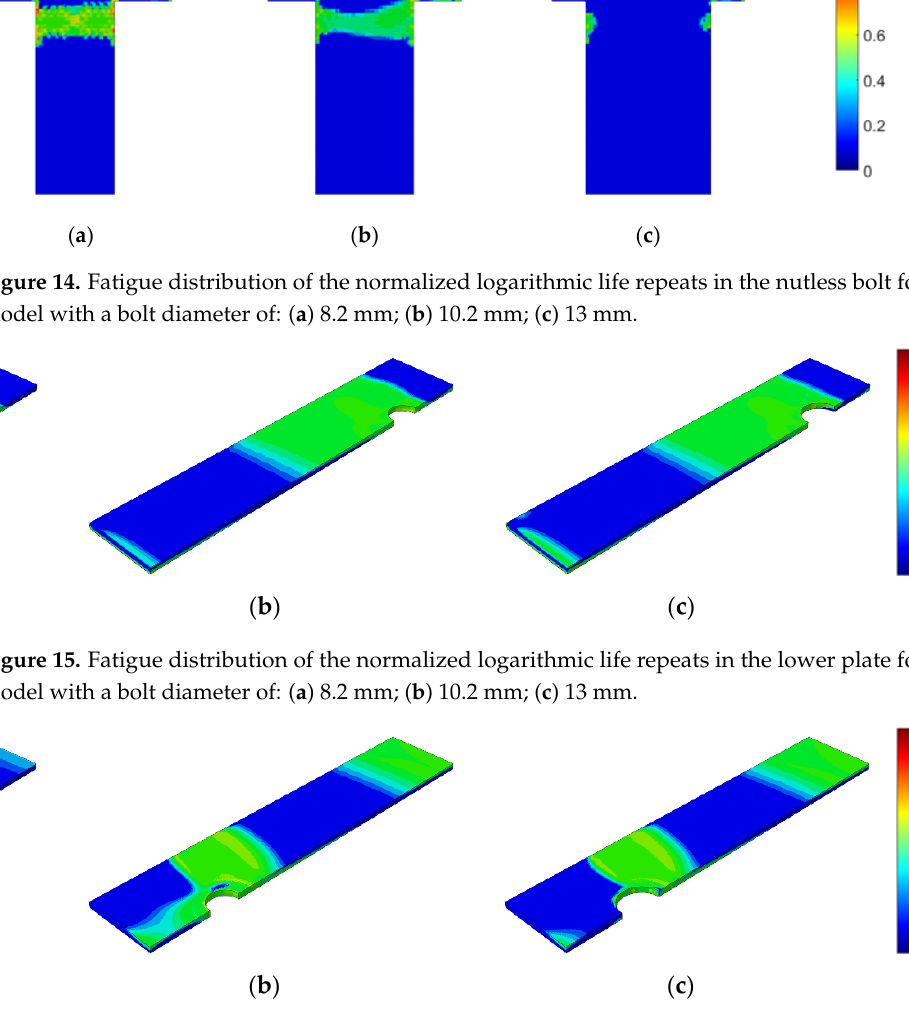
Figure 16. Fatigue distribution of the normalized logarithmic life repeats in the upper plate for the model with a bolt diameter of: ( a ) 8.2 mm; ( b ) 10.2 mm; ( c ) 13 mm.